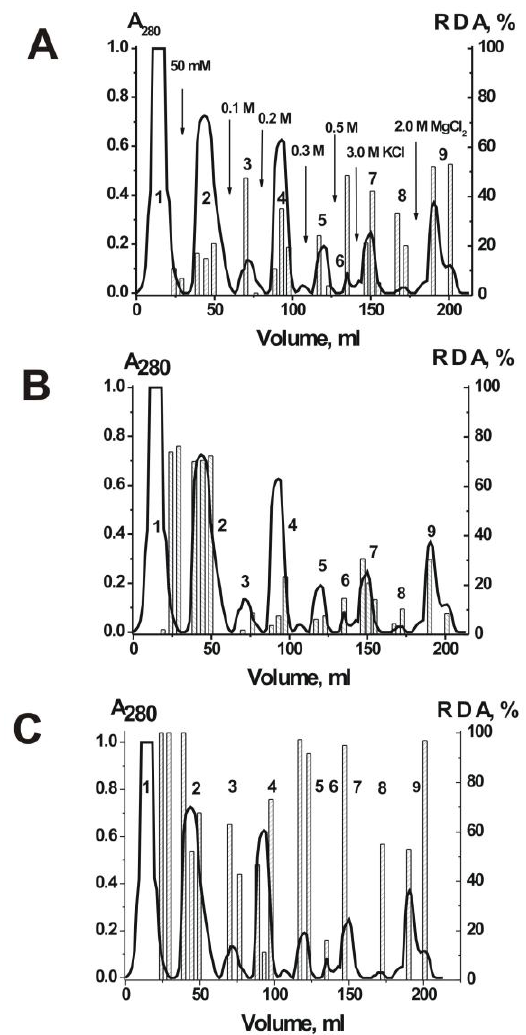
FIGURE 1. Affinity chromatography of a pIgG preparation from the serum of a diseased mouse with high proteinuria on DNA-cellulose: (  ), absorbance at 280 nm (A,B,C)[136]. The relative DNase activity (RDA) of the IgG fractions eluted from the resin by different concentrations of KCl and 2 M MgCl 2 in the presence of Ca 2+ (A), Mg 2+ (B), and Mn 2+ ions (C) is shown by the bars. The relative activity was normalized to standard conditions corresponding to 5 μl of the eluate and 10 min of incubation; the highest RDA among the fractions determined in the presence of Mn 2+ ions (C) was taken for 100%. Errors in the initial rate determination from three experiments for any Me 2+ did not exceed